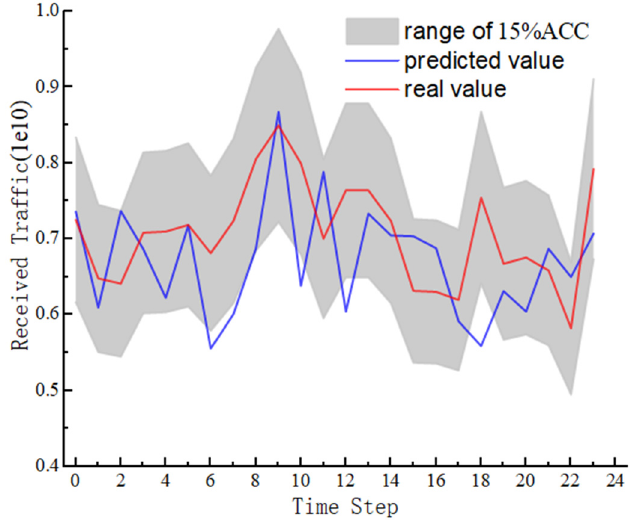
Figure 12. GRU model prediction results.